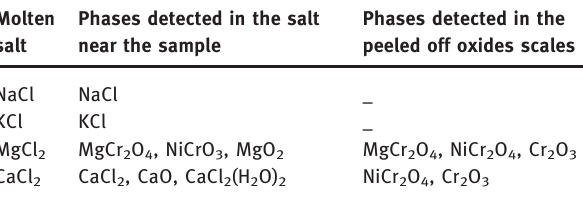
Table 3: Results of the XRD analysis on the salts near the samples after corrosion